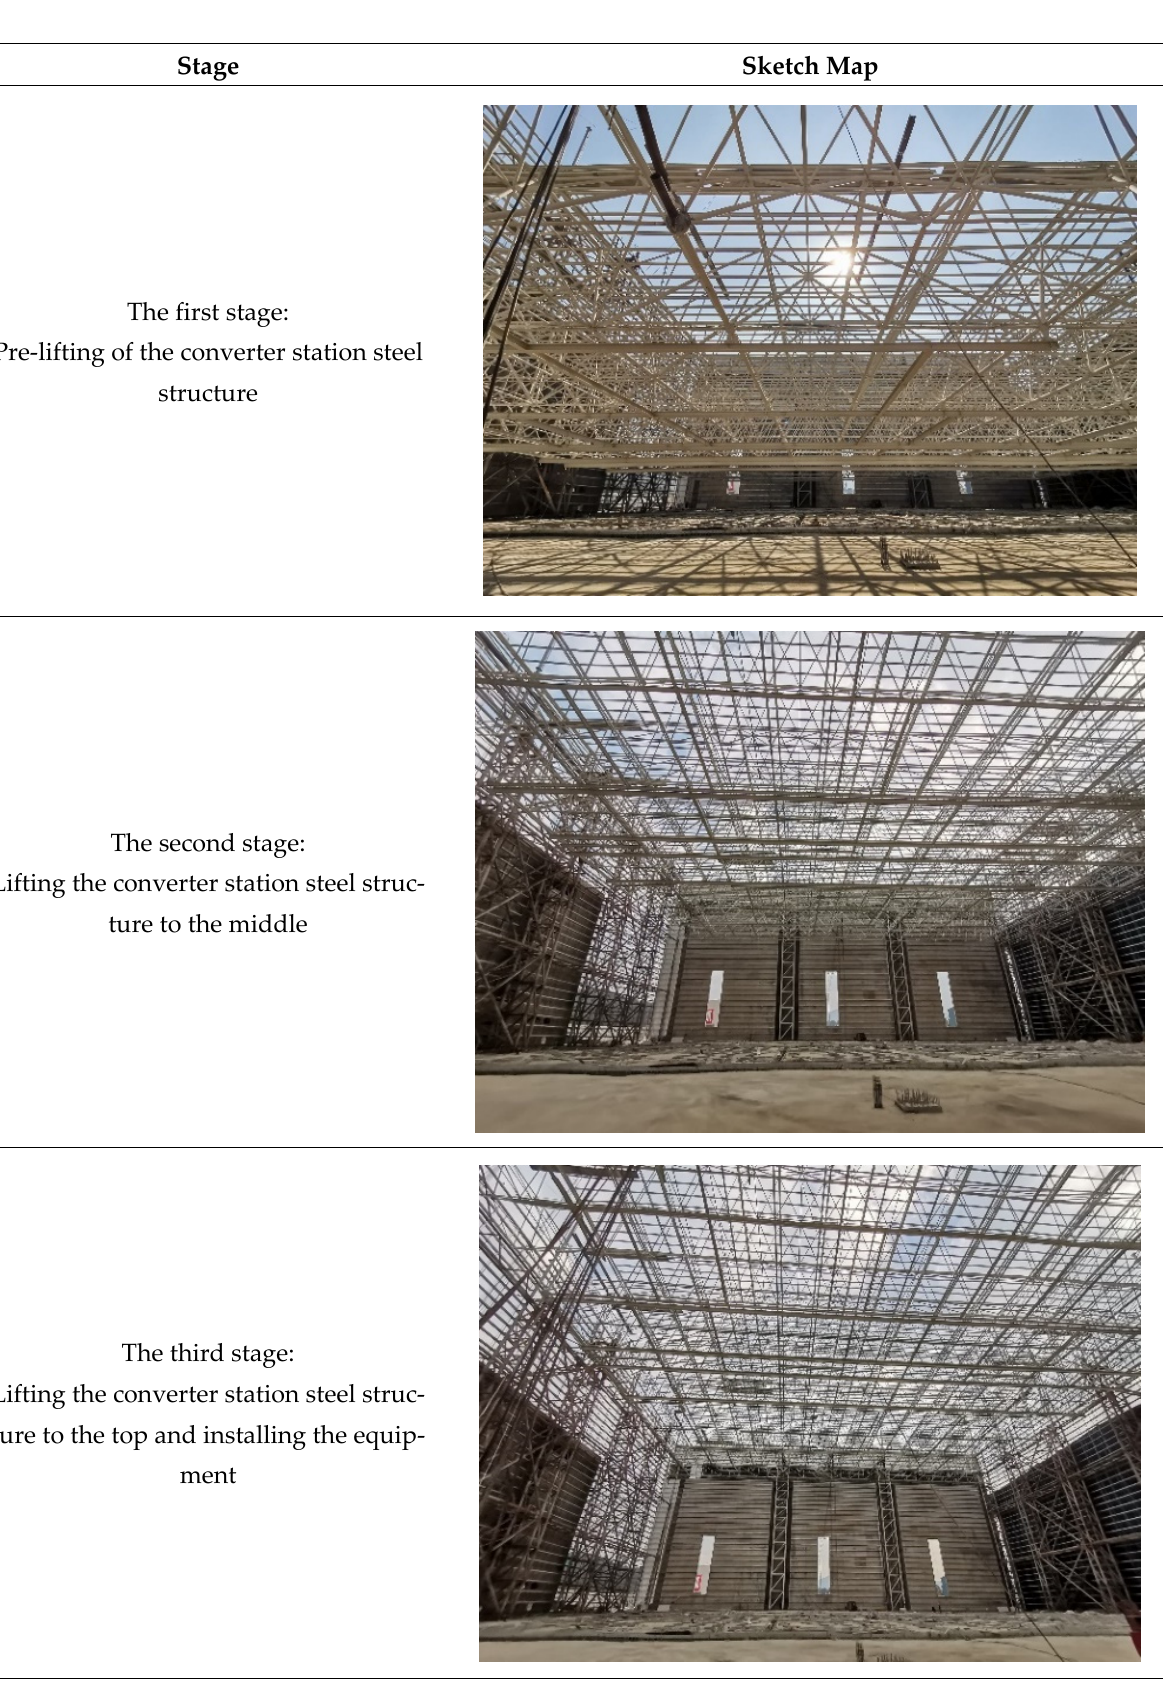
Figure 2. Hoisting stage.